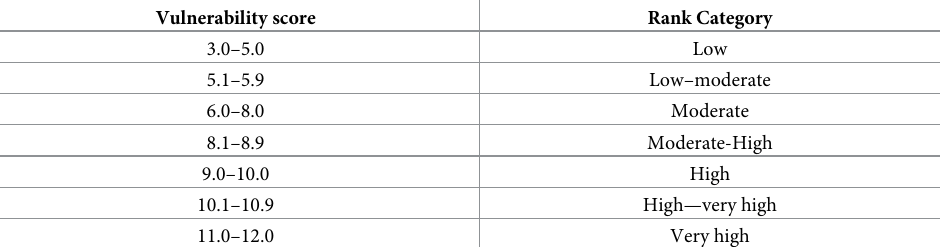
Table 1. Climate change vulnerability scores and rank categories applied across the freshwater